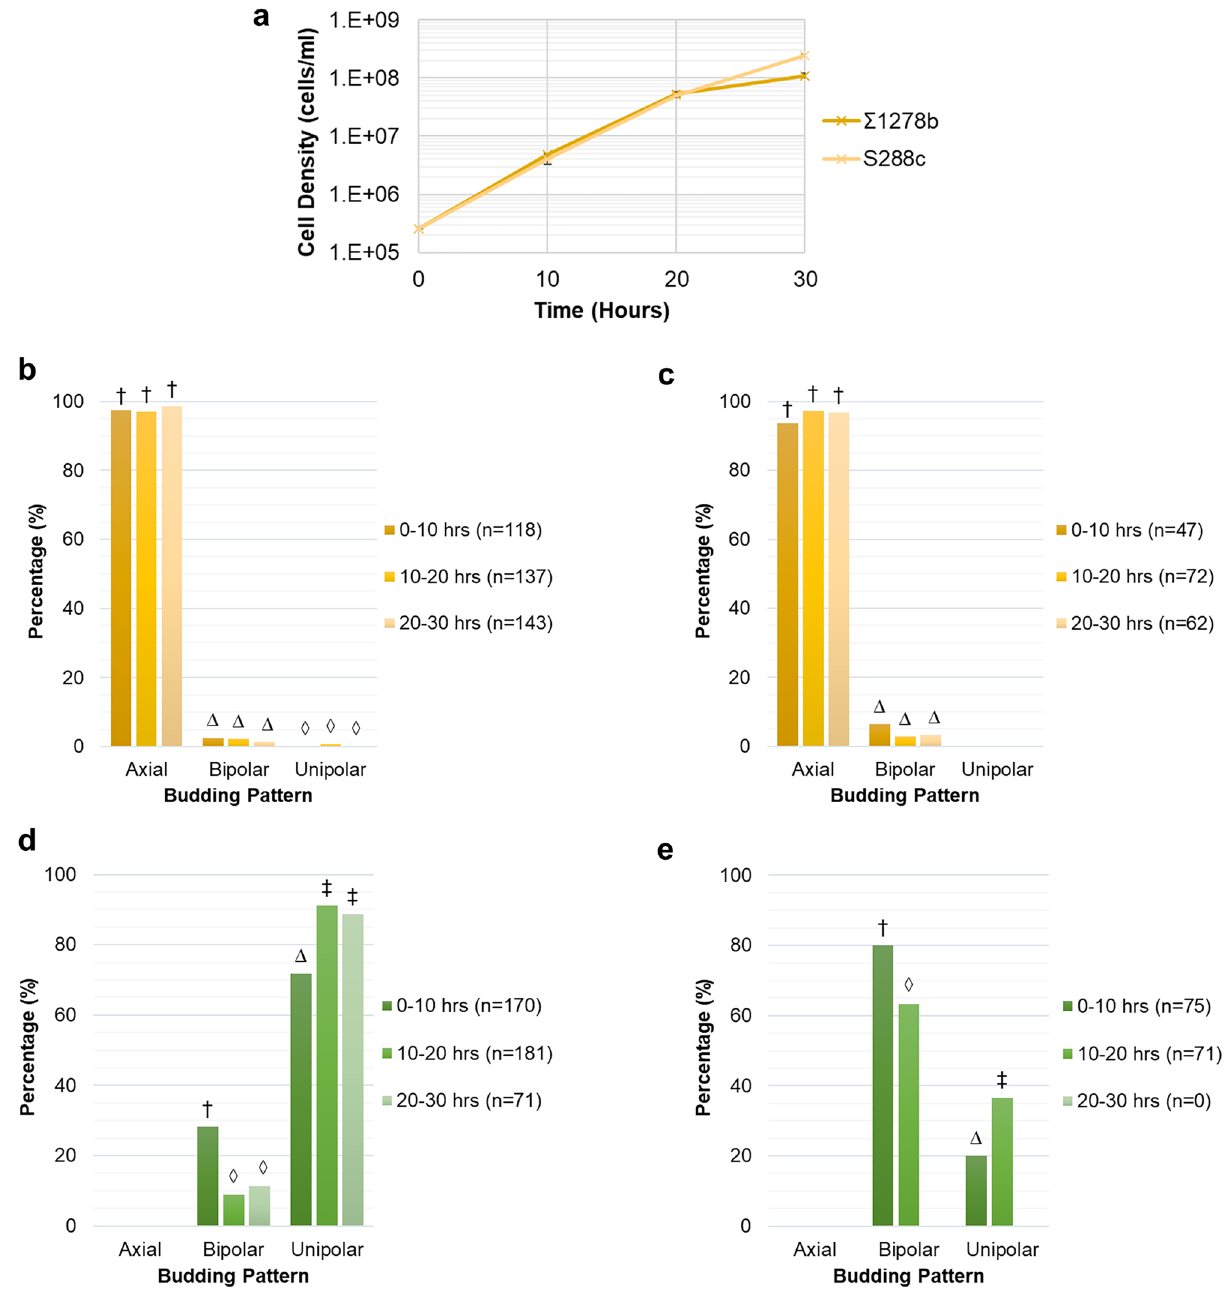
Figure 3. S. cerevisiae strain Σ1278b shows an increase in the filamentous unipolar budding pattern under low nitrogen conditions between local cell densities of 4.8 × 10 6 and 5.3 × 10 7 cells/ml. ( a ) Change in local cell density under low nitrogen conditions measured by cell counting with a hemocytometer. Means and standard deviation for three biological replicates are shown. ( b ) Budding pattern for S288c cells with two bud sites. ( c ) Budding pattern for S288c cells with three bud sites. ( d ) Budding pattern for Σ1278b cells with two bud sites. ( e ) Budding pattern for Σ1278b cells with three bud sites. The percentage of total cells exhibiting each budding pattern are shown. Budding pattern of cells during growth were determined by manual image analysis of time-lapse images obtained using the oCelloScope™. Different symbols indicate a P value of ≤ 0.05 as determined by Fishers Exact